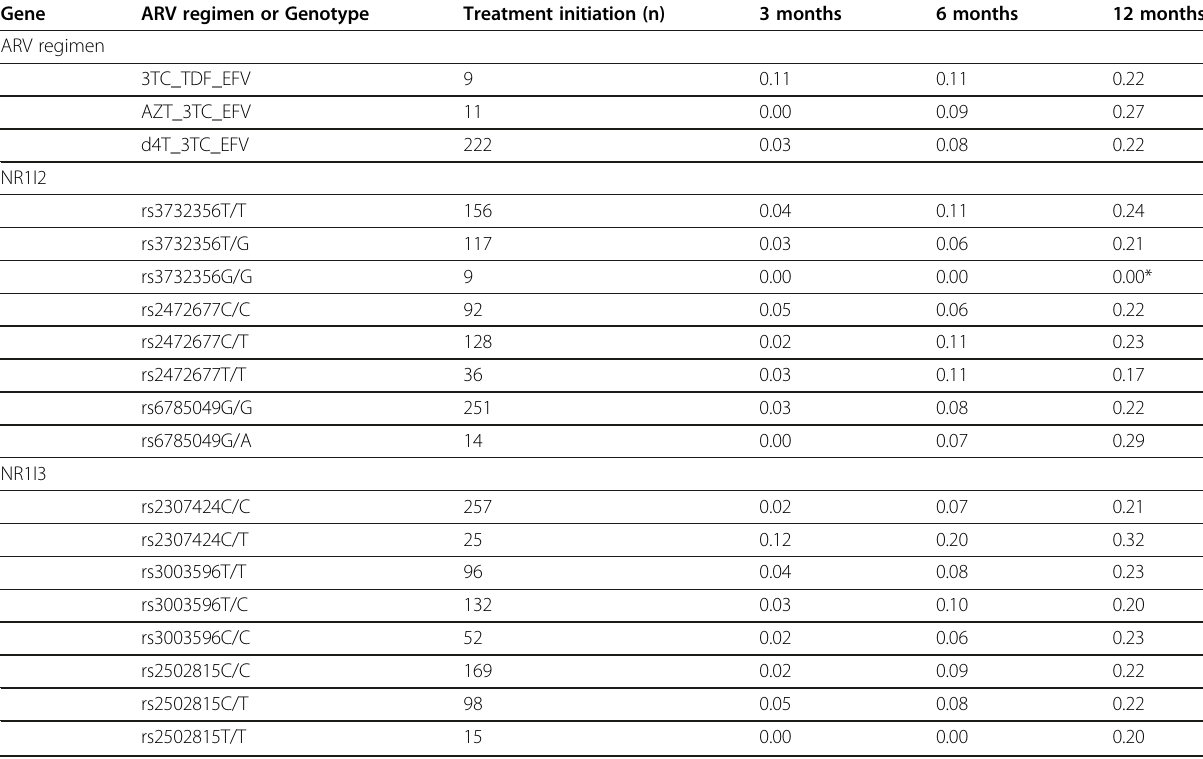
Table 4 Frequency of HIV/AIDS patients changing ART regimens within 3, 6 or 12 months post-initiation of treatment Gene ARV regimen or Genotype Treatment initiation